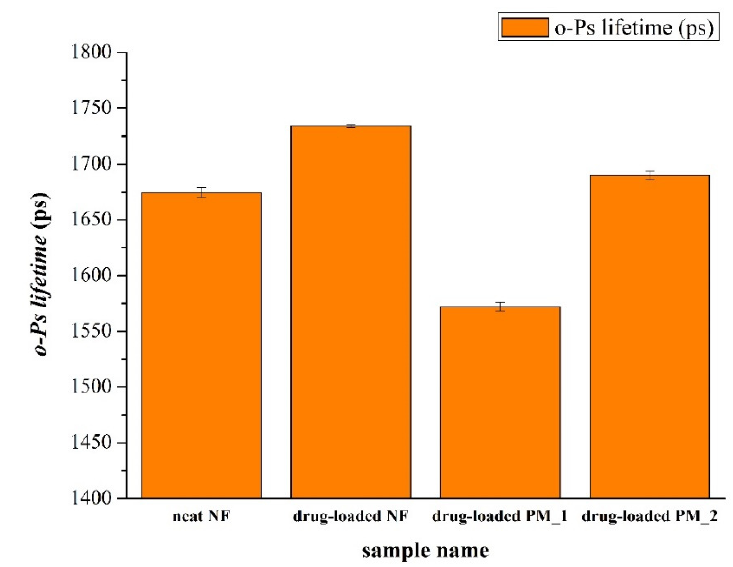
Figure 6. Average o-Ps lifetime values of various samples. neat NF: PVP-based microfibers without polysorbate 80 and FEN; drug-loaded NF: PVP-based microfibers with polysorbate 80 and FEN; drug-loaded PM_1: physical mixture containing PVP and FEN; drug-loaded PM_2: physical mixture containing PVP, fenofibrate, and polysorbate